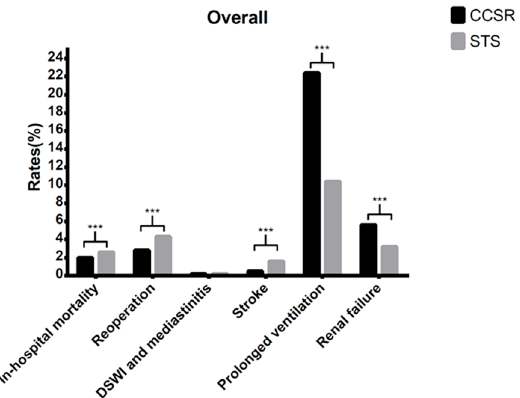
Figure 3. Comparison of outcomes in the whole cohort between CCSR and STS procedures. CCSR: